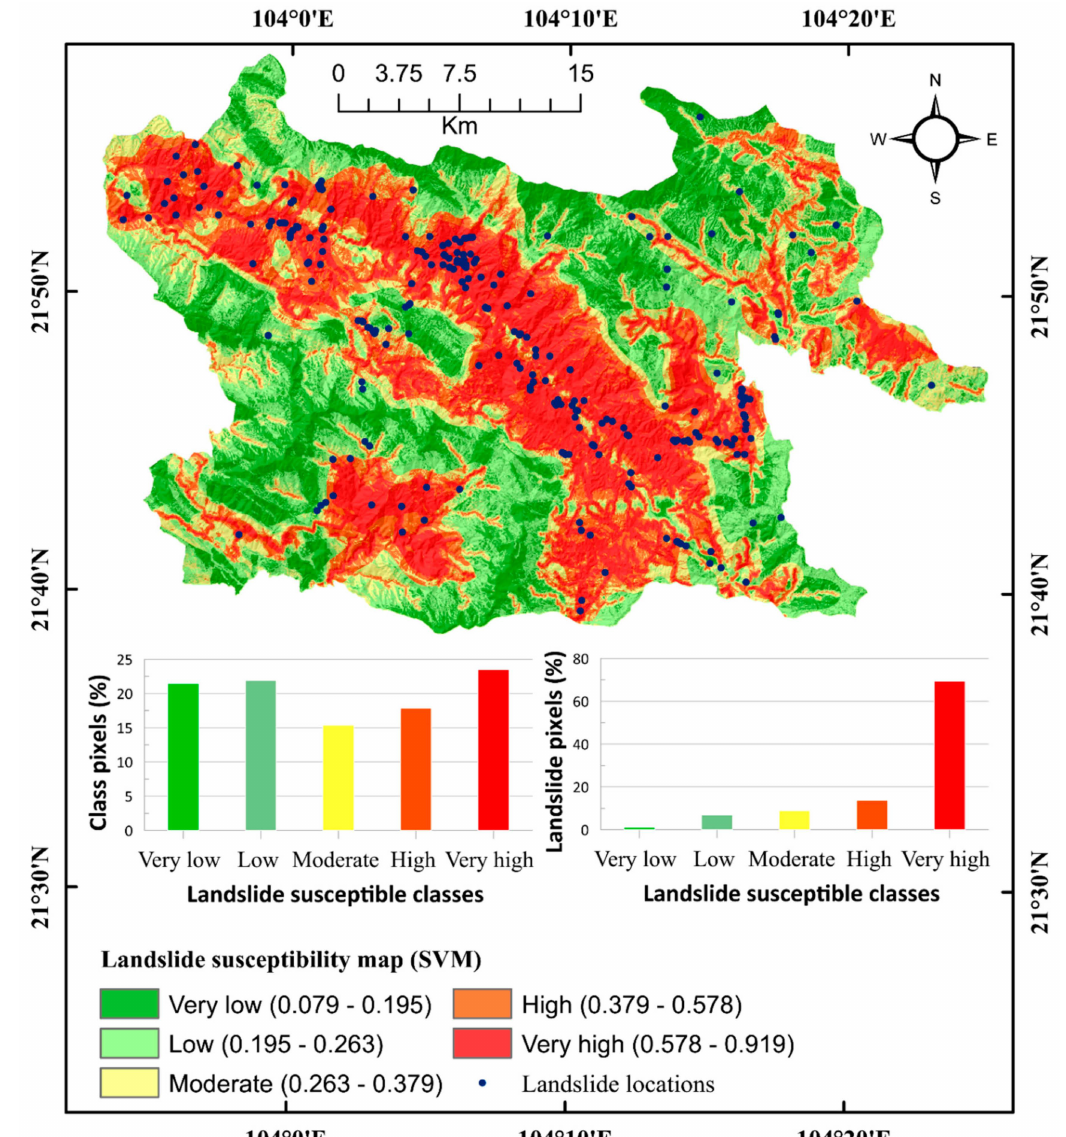
Figure 9. Landslide Susceptibility Map (LSM) of the study area based on the SVM